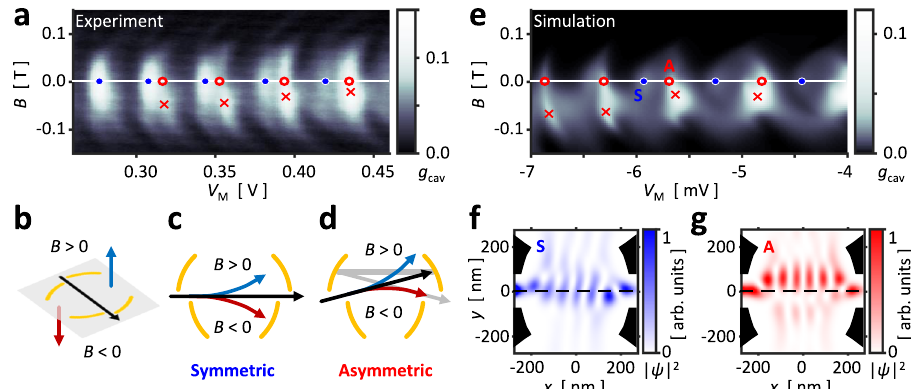
Fig. 5 | Cavity mode distribution. a Magnetoconductance g cav measured in con fi guration 2a as a function of anout-of-plane magnetic fi eld B asin b . The fi eld de fl ects the electrons either towards reservoir O1 or O2, depending on the sign of B . c For electronic modes lying on the cavity axis, a nonzero fi eld diminishes g cav symmetrically for both signs of B (blue circles in a ). d For electronic modes lop- sided across the cavity axis, g cav decreases for a sign of B but increases for the oppositesignastheelectronsarerefocused towardsthemirrorcenter(red circles